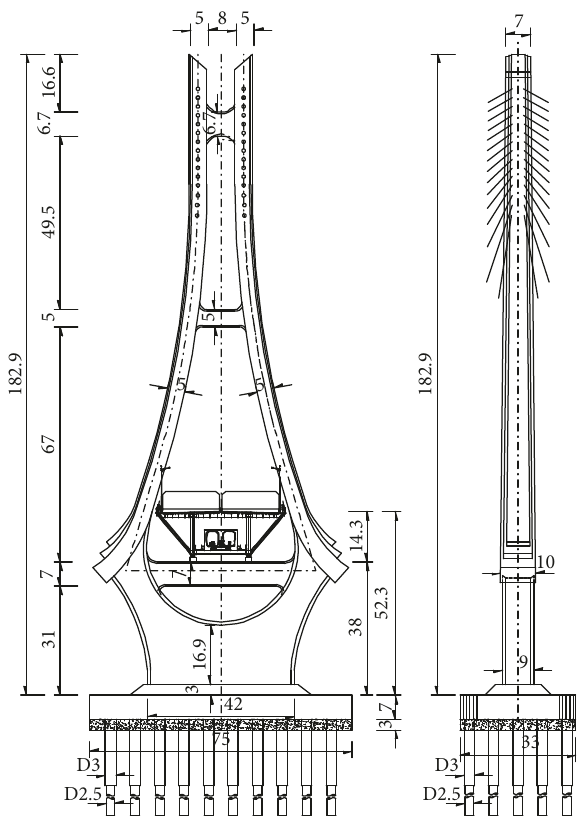
Figure 3: Elevation of main tower (unit: m). Table 1: Coefficient matrices for each time instant. Coefficient Time instant